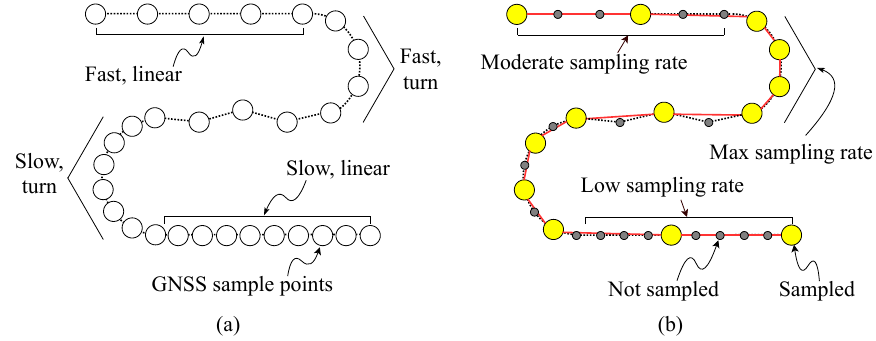
Figure 5. ( a ) A trajectory recovered by the baseline sampling associated with the fully-activated GNSS module and ( b ) a trajectory recovered by the activity-aware sampling with the reduced number of GNSS